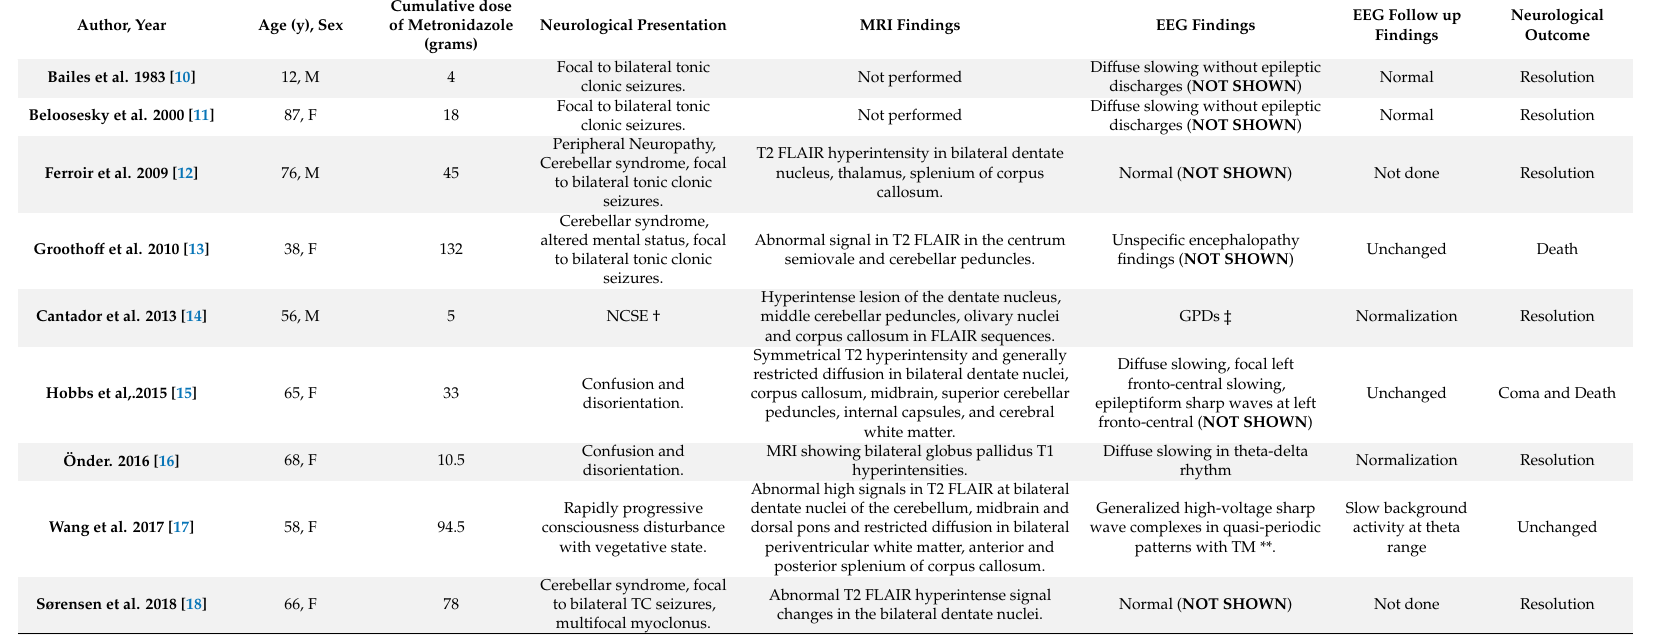
Table 1. Review of EEG findings and clinical outcomes of MIE case